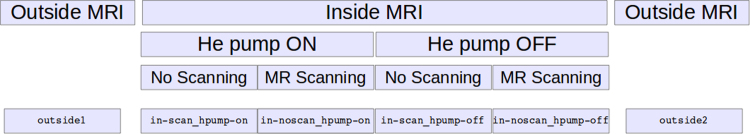
Filename convention in the EEG data set. The bottom row identifies the condition part of the EEG data file names. The conditions are: (1) outside, before going in the MRI scanner, (2) inside the MRI scanner, without scanning and the Helium pump ON, (3) inside the MRI scanner, with scanning and the Helium pump ON, (4) inside the MRI scanner, without EPI scanning and with the Helium pump OFF, (5) inside the MRI scanner, with EPI scanning and with the Helium pump OFF and finally (6) outside, after coming out of the MRI scanner. For test-retest purposes: in-noscan measurements were always performed before in-scan measurements..